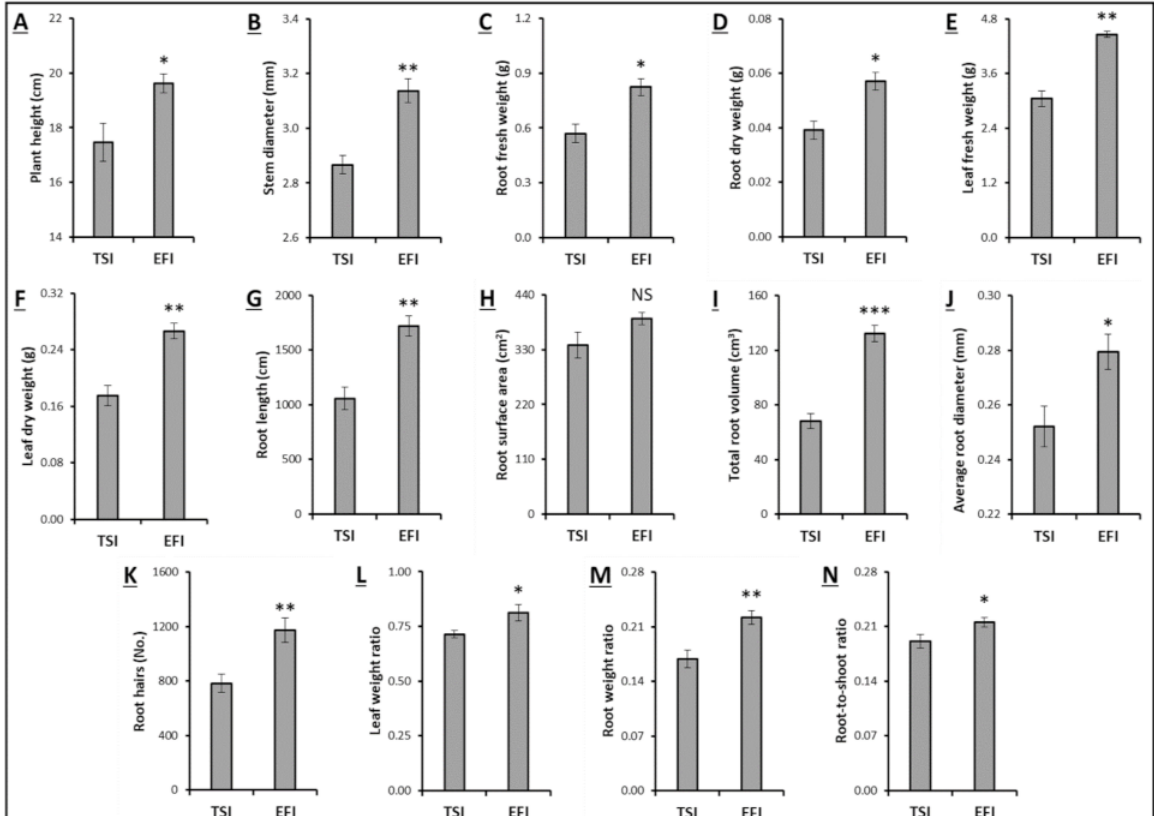
Figure 2. Effect of top sprinkle (TSI) and ebb-and-flow (EFI) irrigation on morphological at- tributes of tomato seedlings. Vertical bars indicate means ± SE ( n = 3, 10 plants per replicate). The *, ** and *** represent significance at p ≤ 0.05, p ≤ 0.01 and p ≤ 0.001, respectively, according to Student’s t -test. NS–not